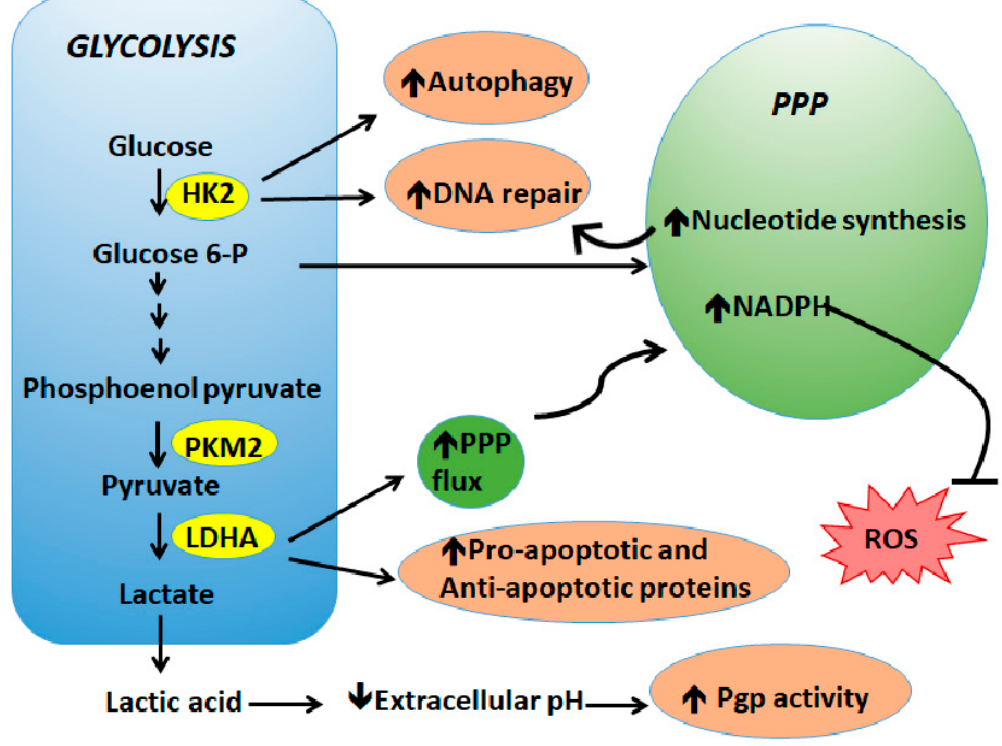
Figure 2. Metabolic deregulations lead to drug resistance. The metabolic shift favors cancer cell proliferation and survival in response to therapy via upregulation of DNA repair, increase of prosurvival signaling and autophagy, activation of drug efflux pumps, and neutralization of ROS.